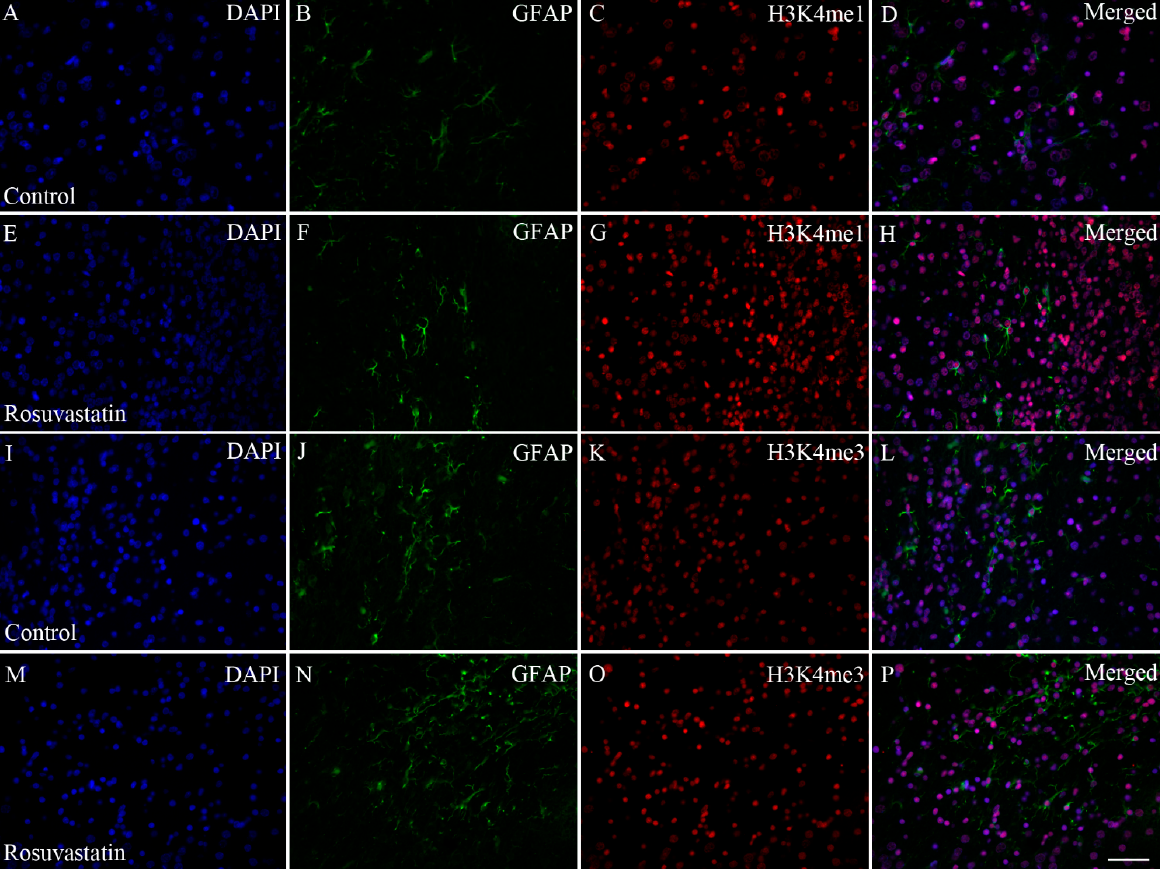
Figure 11. Double immunofluorescence staining for H3K4me1 and H3K4me3 in GFAP-positive astrocytes. In the neonatal rat brains, GFAP-positive cells were few, and unevenly distributed (green; B , F , J , N ). DAPI-labeled cell nuclei are blue ( A , E , I , M ), and H3K4me1 ( C , G ) and H3K4me3 ( K , O ) marks are shown here in red. Merged pictures show ( D , H , L , P ) that few GFAP-positive astrocytes exhibited H3K4me1 and H3K4me3 marks. Scale bar: 50 µm.